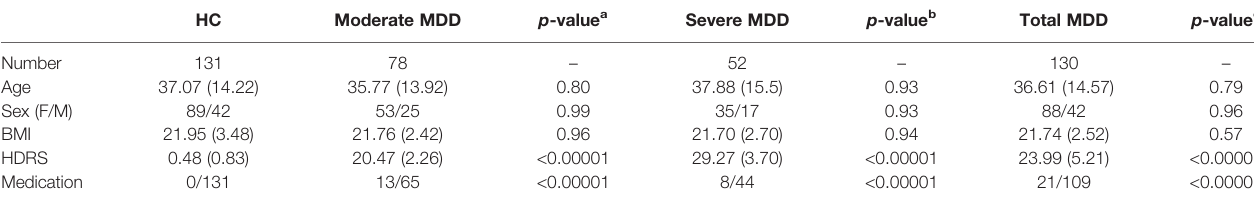
TABLE 1 | Characteristics of the included